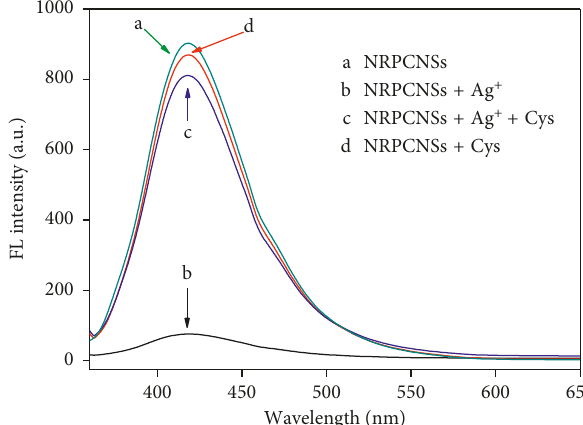
Figure 1: FL spectra of (a) NRPCNSs (20 μ g/mL), (b) NRPCNSs (20 μ g/mL) +Ag + ion (80 μ M), (c) NRPCNSs (20 μ g/mL) +Ag + ion